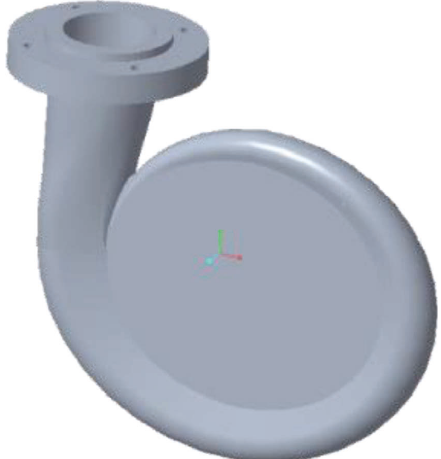
Figure 2: Three-dimensional view of the cochlear